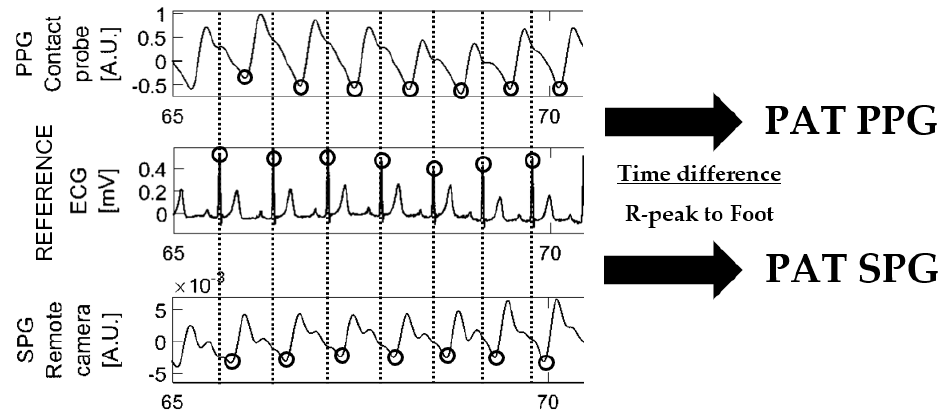
Figure 3. Example of Pulse Arrival Time (PAT) calculation on PPG and